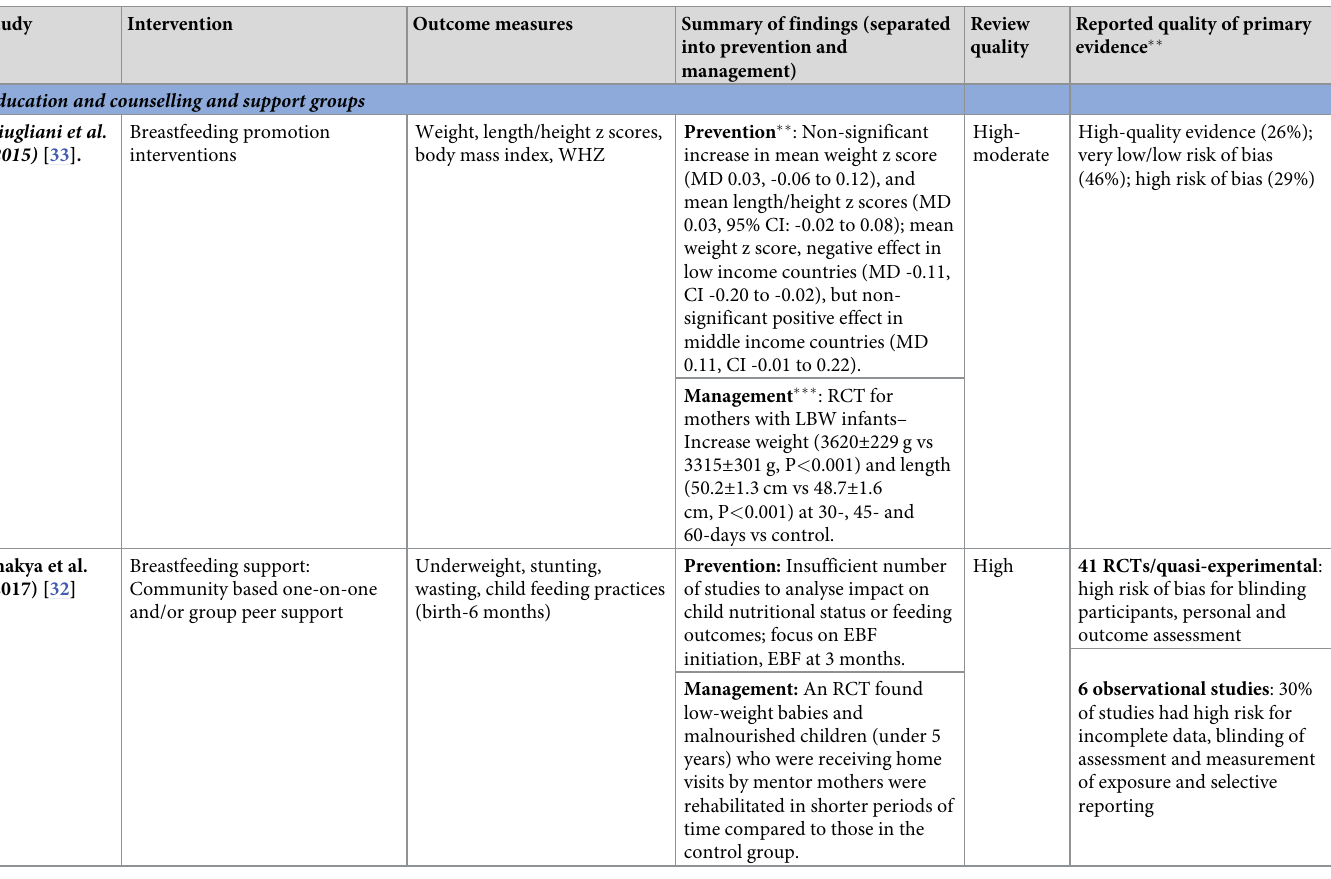
Table 1. Summary of maternal non-supplementation interventions during lactation and pregnancy-reviews. Study Intervention Outcome measures Summary of findings (separated